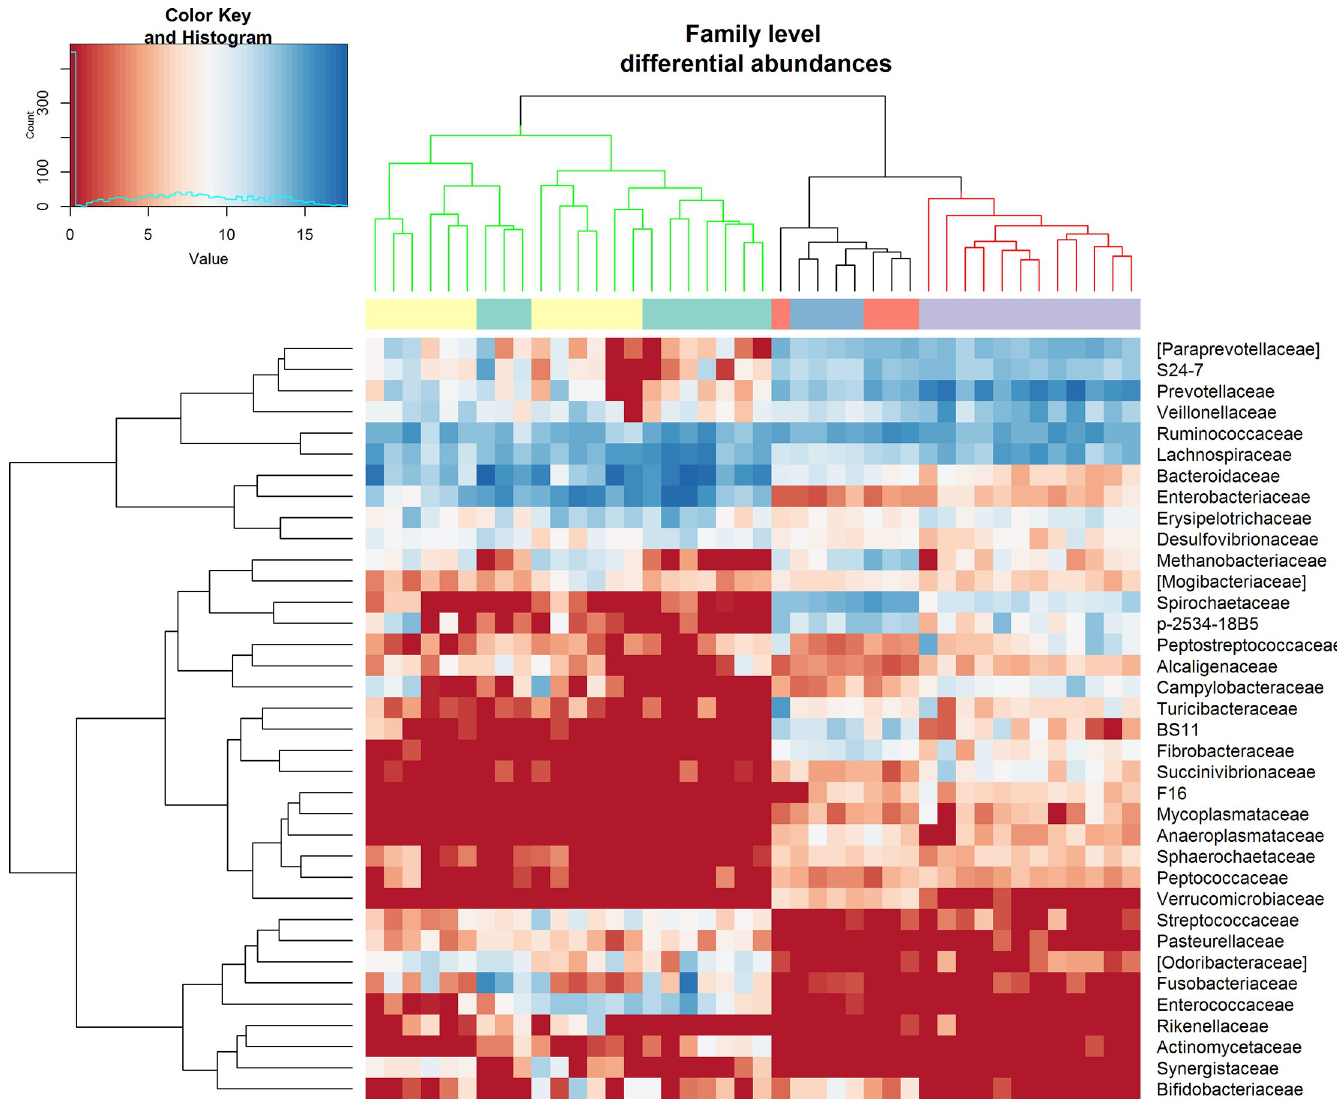
Fig 3. Family Heatmap and hierarchical clustering. The listed families showed significant differential abundances between suckling piglets and weaned piglets and between weaned piglets and sows (see also S7 and S8 Figs). Upper bar: green = piglets timepoint I; yellow = piglets timepoint II; purple = piglets timepoint II, orange = sows timepoint I; blue = sows timepoint II. Upper dendrogram: green branches = pre-weaning piglets; red branches = post-weaning piglets; black branches = sows. The family abundances were normalized by cumulative sum scaling and log2 transformed in metagenomeSeq package.